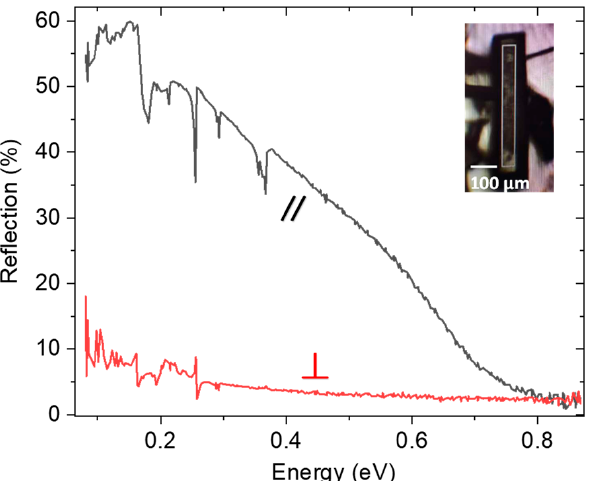
Figure 4. Polarized IR reflectance spectrum of crystal 1 at room temperature. Inset is the optical image of the crystal. Black line: excitation along the direction of the crystal. Red line: excitation perpendicular to the direction of the crystal.